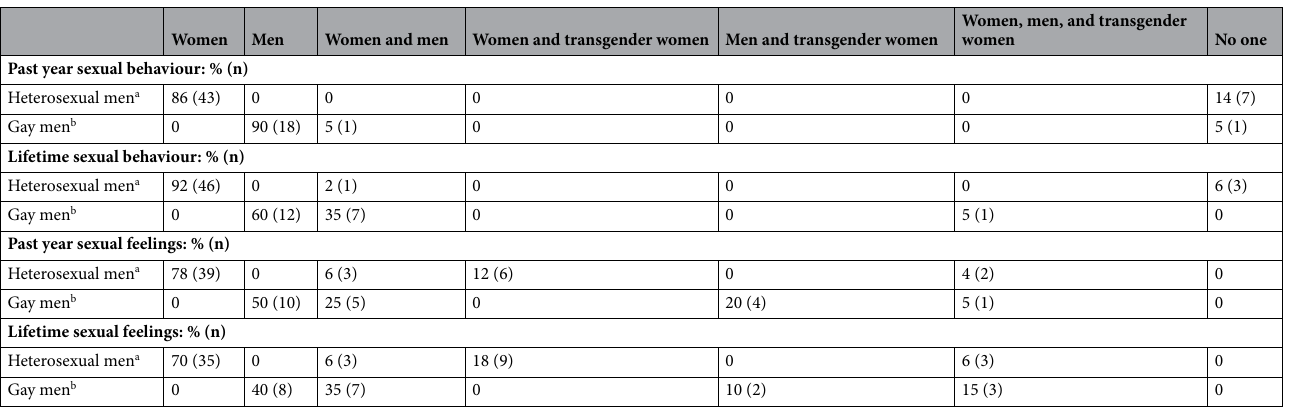
Table 1. Self-reported sexual behavior and feelings. a N = 50. b N =